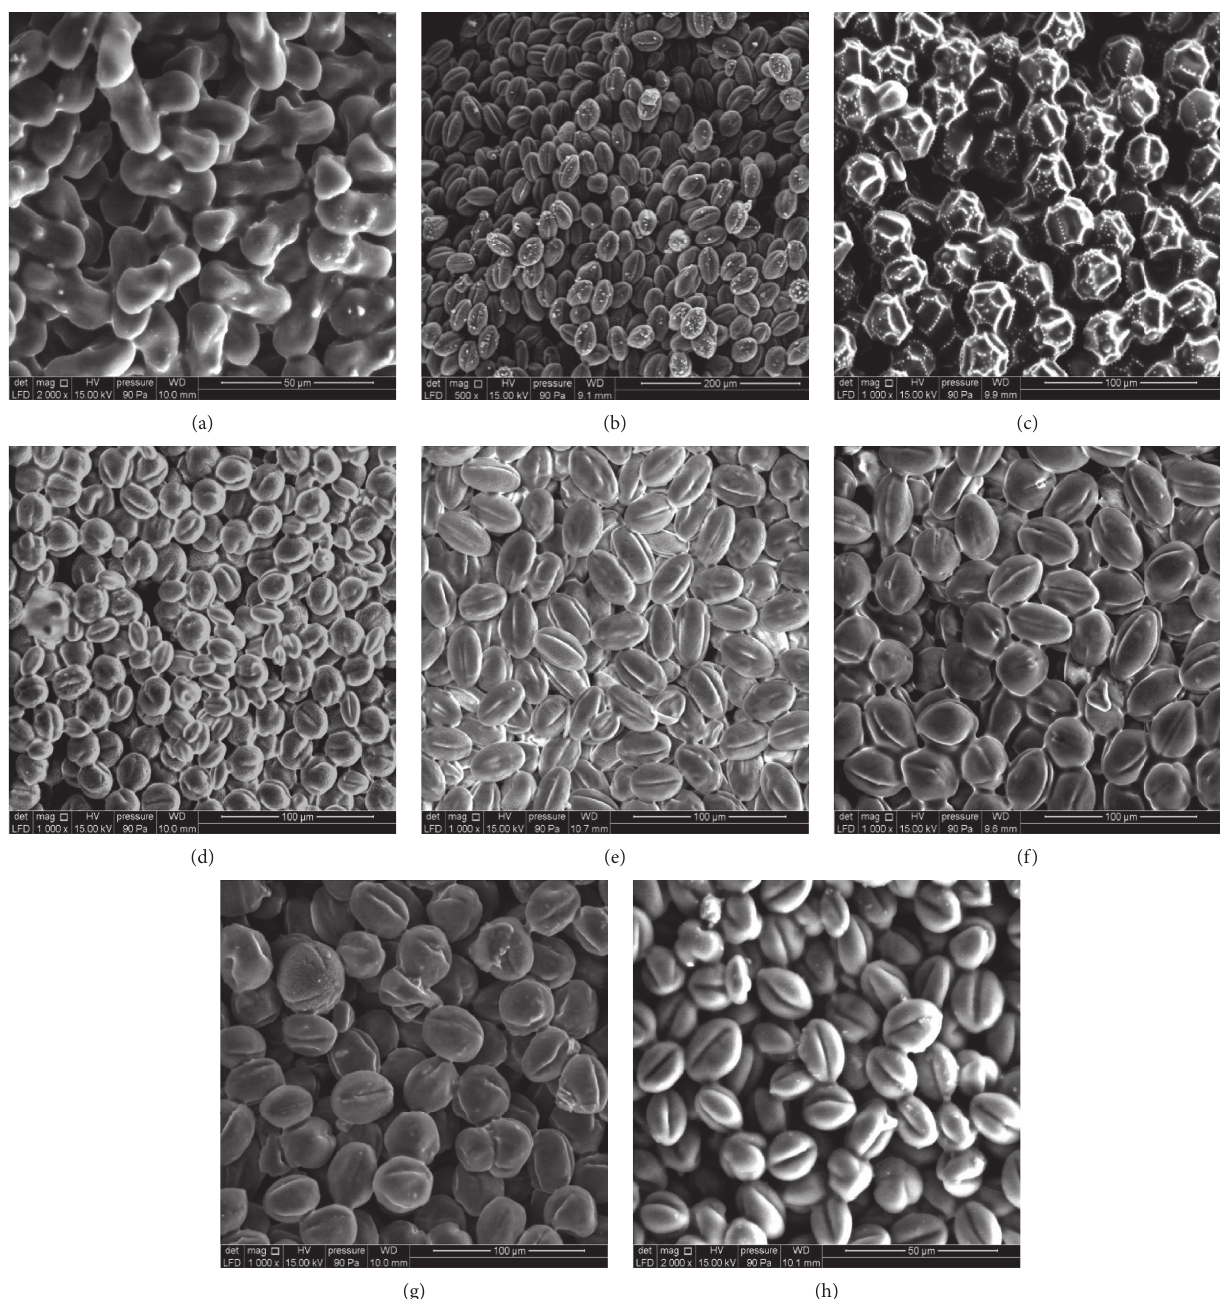
Figure 1: Scanning Electron Microscopy (SEM) micrographs of 193 bee pollen samples. (a) P1: Coriandrum sativum (Apiaceae). (b) P2: Ulex europaeus (Fabaceae). (c) P3: Scorzonera cana (Asteraceae). (d) P4: Trifolium pretense (Fabaceae). (e) P5: Ulex europaeus (Fabaceae). (f) P6: Reseda luteola (Resedaceae). (g) P7: Spiraea salicifolia (Rosaceae). (h) P8: Lamium galeobdolon